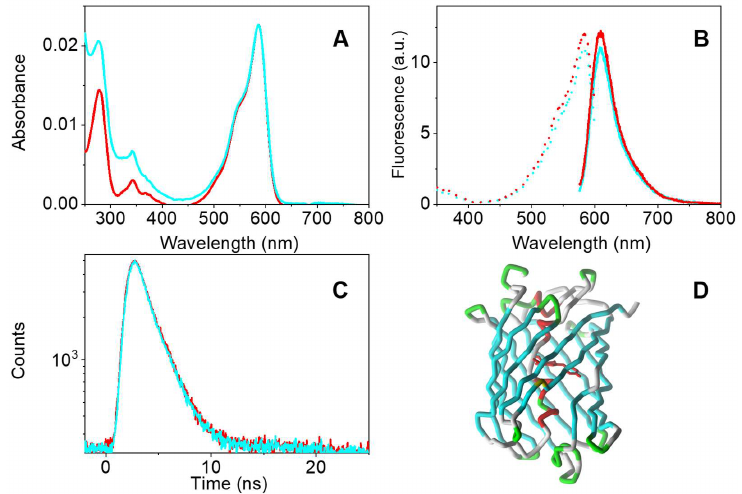
of [NO] = 250 µ M (cyan). ( B ) Fluorescence excitation (dotted lines) and emission (solid lines) spectra of a mCherry solution equilibrated with N 2 (red) and in the presence of [NO] = 250 µ M (cyan). ( C ) Fluorescence decays of mCherry solution equilibrated with N 2 (red) and in the presence of [NO] = 250 µ M (cyan). ( D ) Schematic structure of mCherry with the chromophore displayed as red sticks (pdb code